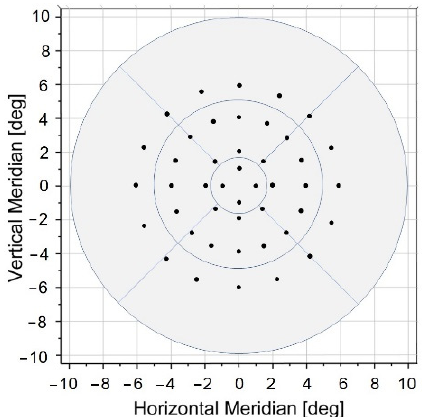
Figure 3. Grid point distribution superimposed over a macular thickness map with radial sector borders corresponding to 1 mm, 3 mm, and 6 mm borders corresponding to 1 mm, 3 mm, and 6 mm ETDRS.